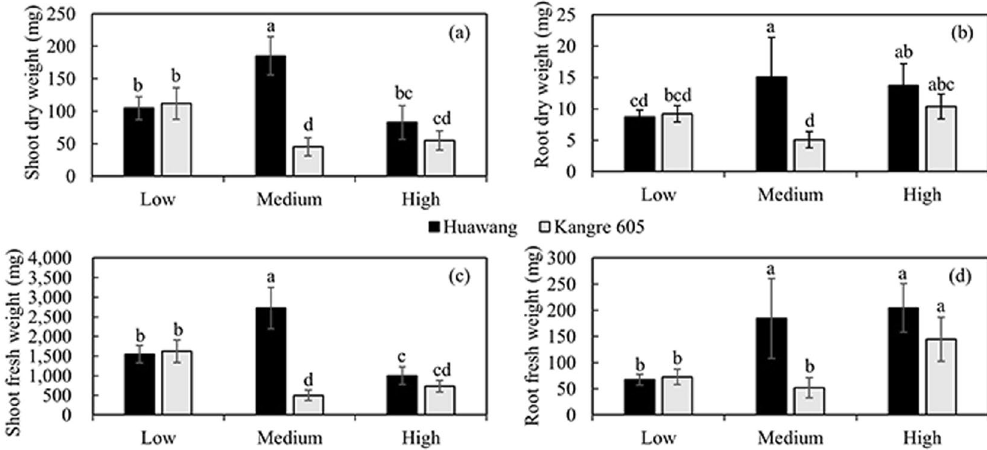
Figure 1. Effects of different water treatments on the growth of two pakchoi cultivars. ( a ) Shoot dry weight per plant under three different root zone water content treatments, 40% (low), 60% (medium), and 80% (high) relevant water content, ( b ) root dry weight per plant under three treatments, ( c ) shoot fresh weight under three treatments, and ( d ) root fresh weight per plant under three treatments. Means with the same letter are not significantly different (P > 0.01). One half-bar represents the standard